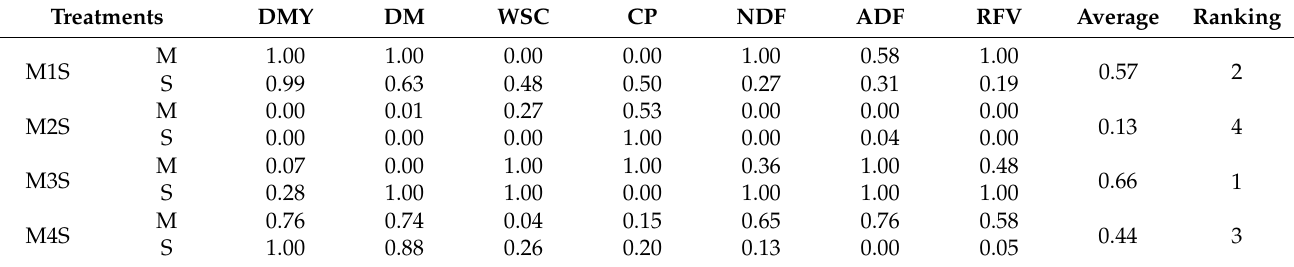
Table 6. Membership function analysis of forage utilized for fresh feeding.